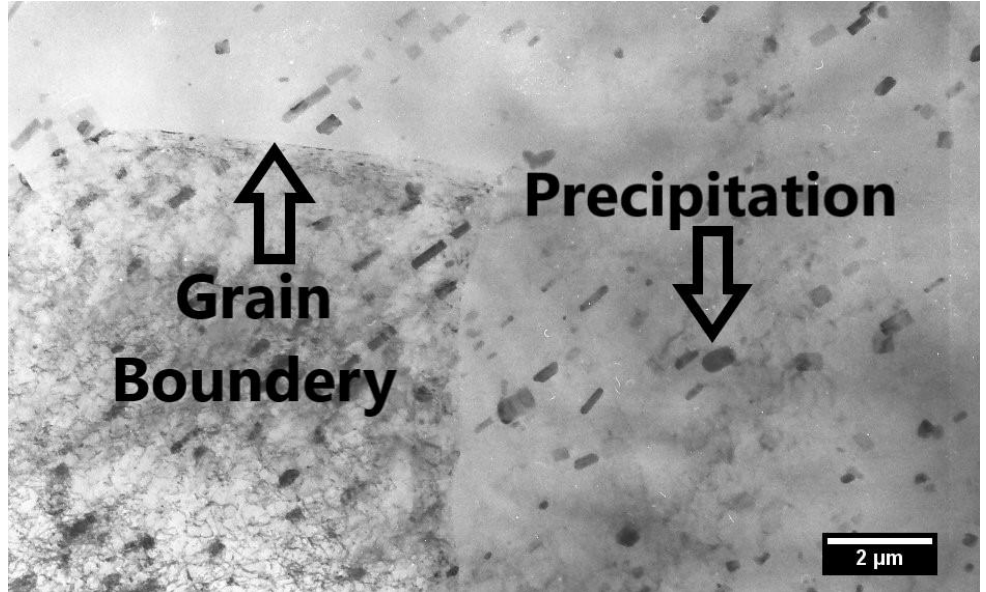
Figure 7. Transmission electron microscope (TEM) images detailing the microstructure of the BM.